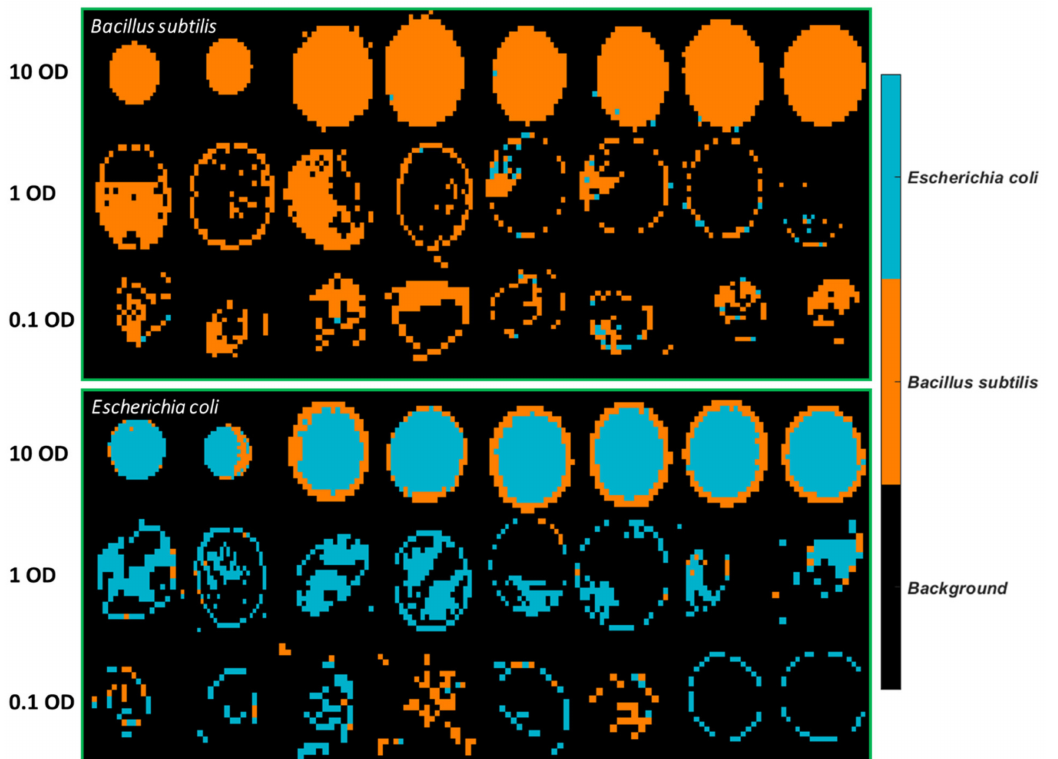
Figure 7. Classification maps obtained from the PLSDA model using 3500–2600 cm − 1 for samples deposited on STS with the 1 OD samples as the training